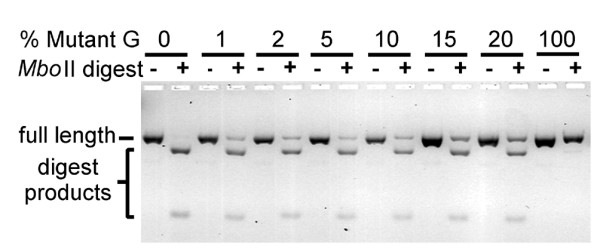
Agarose gel electrophoresis of control PCR products with and without digestion with MboII.